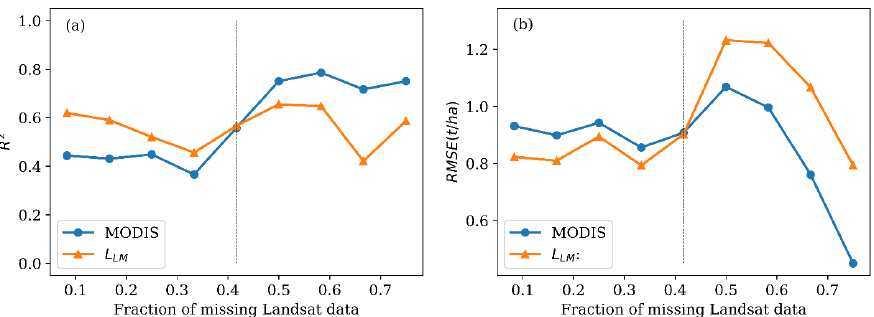
Figure 6. The statistical analysis of missing data in Landsat for 25-m pixel-level yield prediction, by evaluating ( a ) R 2 and ( b ) RMSE against the fraction of Landsat missing data during the growing season. L–M blended data were used to fill the gaps ( L LM ) in the incomplete Landsat series.